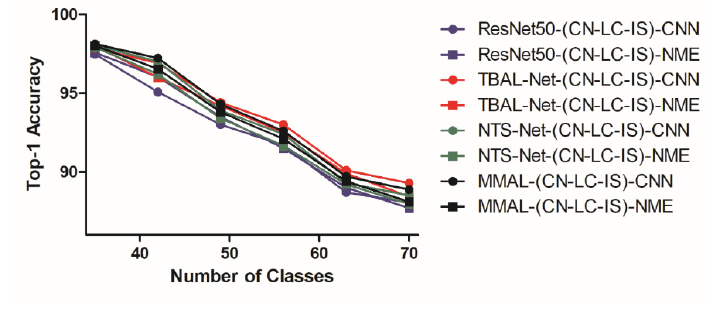
Figure 4. The performance of different number of incremental phases on CUB-200-2011.